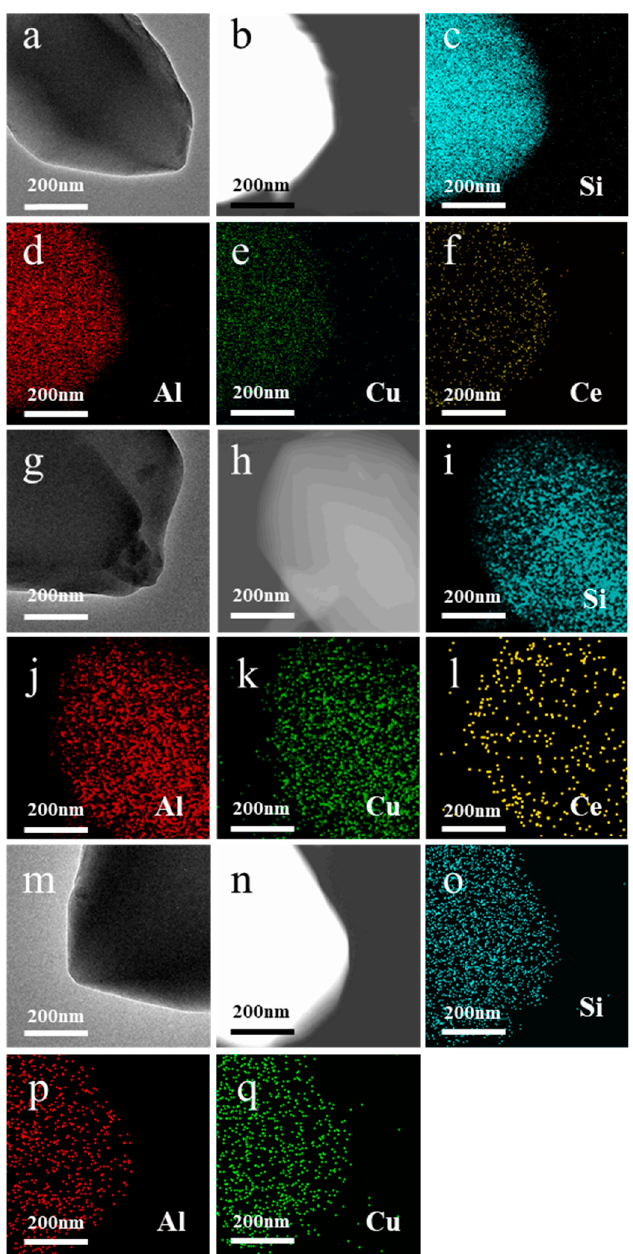
Figure 5. TEM in bright and dark fi elds and EDS mapping images of CuCe 0.87 -SSZ-16-Fresh ( a – f ), CuCe 0.77 -SSZ-16-Fresh ( g – l ), and Cu-SSZ-16-Fresh ( m – q ). CuCe 0.77 -SSZ-16-Fresh ( g – l ), and Cu-SSZ-16-Fresh ( m – q